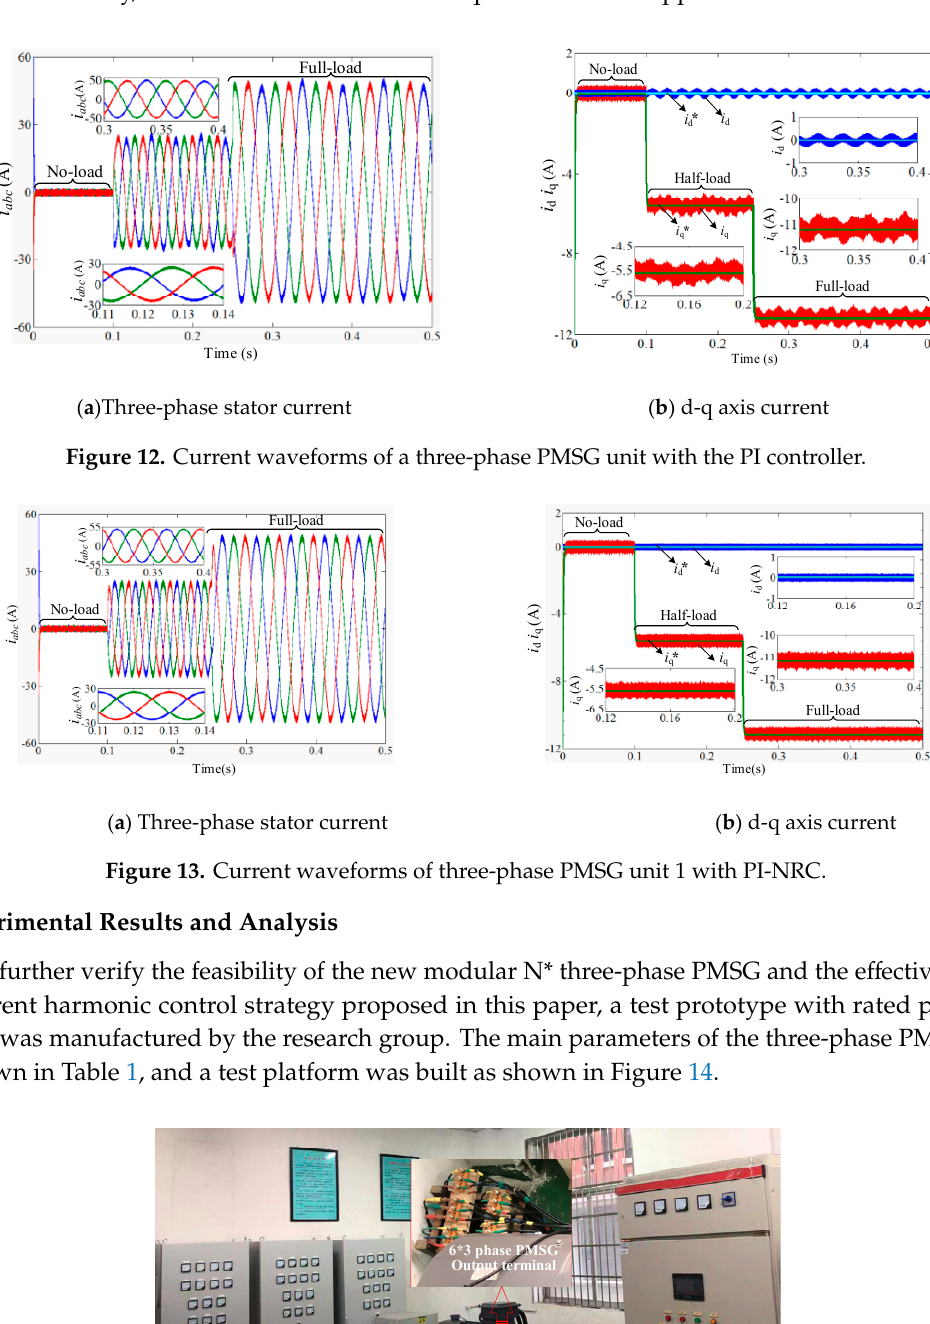
Table 1. Main parameters of a three-phase PMSG unit. Parameters